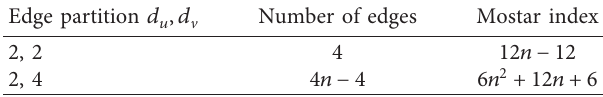
Table 24: Edge partition of para chain of odd order.